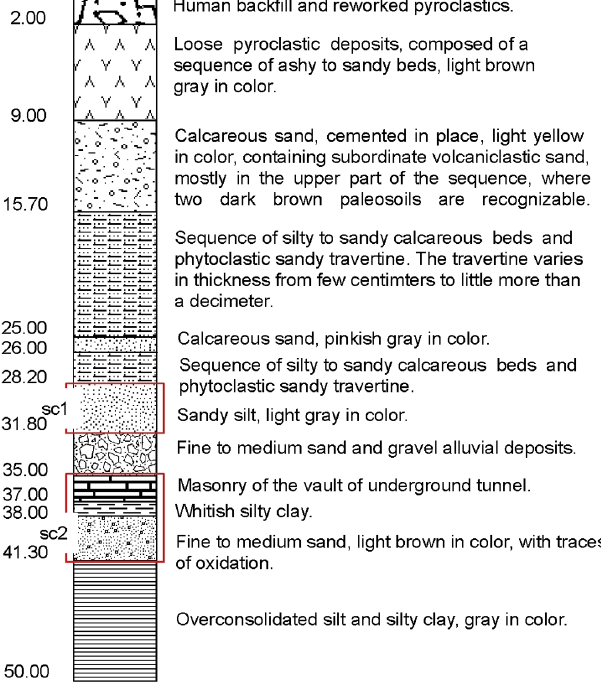
Fig. 7. Stratigraphic sequence of SC3 continuous core borehole. On the left, numbers indicate the depth from ground level. Leg- end: (sc1) terrains affected by the presence of the upper system of cavities; (sc2) terrains affected by the presence of the lower cavity system (WWII air-raid shelter).